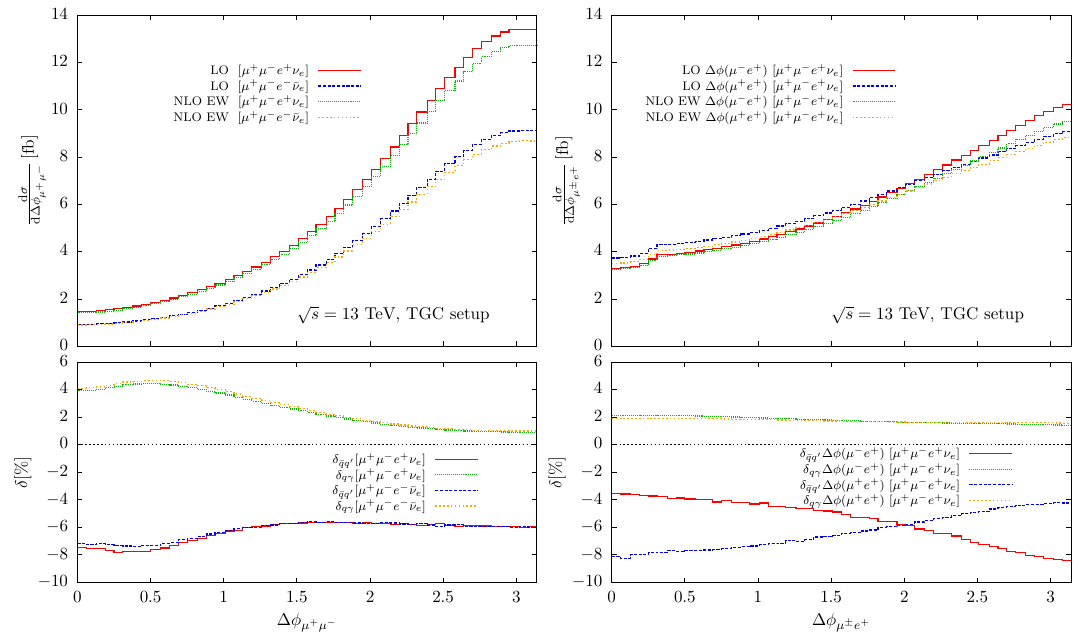
Figure 7 . Distributions in the azimuthal-angle difference of the charged leptons in the TGC setup for the mixed-flavour case. The left panel shows the correlation between the µ + µ − pair for ZW + and ZW − . In the right panel, the correlations between the µ − e + pair and the µ + e + pair are plotted for the ZW +